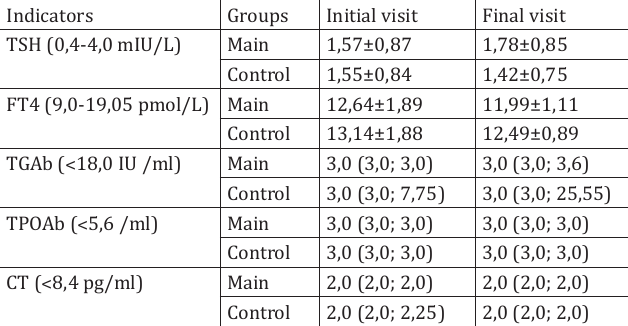
Laboratory tests results of both groups (average values)